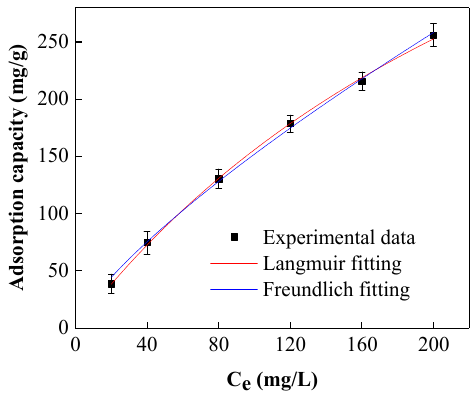
Figure 7. Adsorption isotherms of RB5 onto Ct-PAC-HDA beads (30 mg of beads, pH = 4, 25 ◦ C, 24 h). Table 2. The constants obtained from the isotherm parameters for adsorption of RB5 onto Ct-PAC-HDA beads. Isotherm